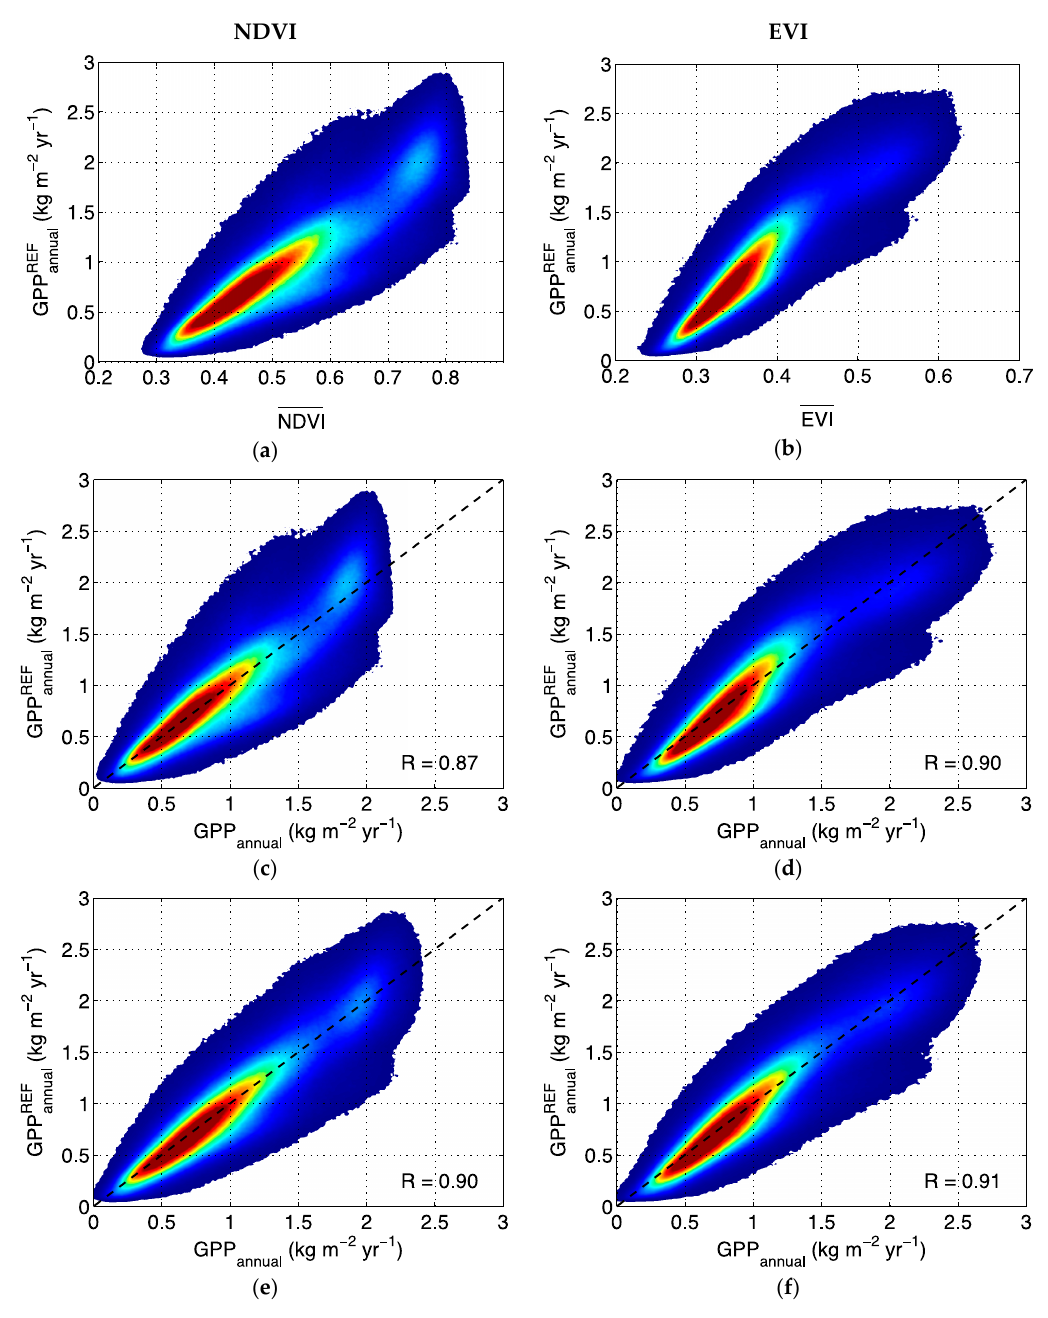
Figure 4. A density plot including all image pixels and all years evidences the correlation between: ( a ) GPP REF and NDVI ; and ( b ) GPP REF and EVI . Correlation between GPP REF and GPP annual estimated by the semi-empirical model with a constant conversion efficiency using: ( c ) NDVI; and ( d ) EVI. Correlation between GPP REF and GPP annual estimated by the semi-empirical model with a conversion efficiency depending on the land-cover type using: ( e ) NDVI; and ( f ) EVI (Reddish areas correspond to the highest point density. The dashed line is the 1:1 bisector).